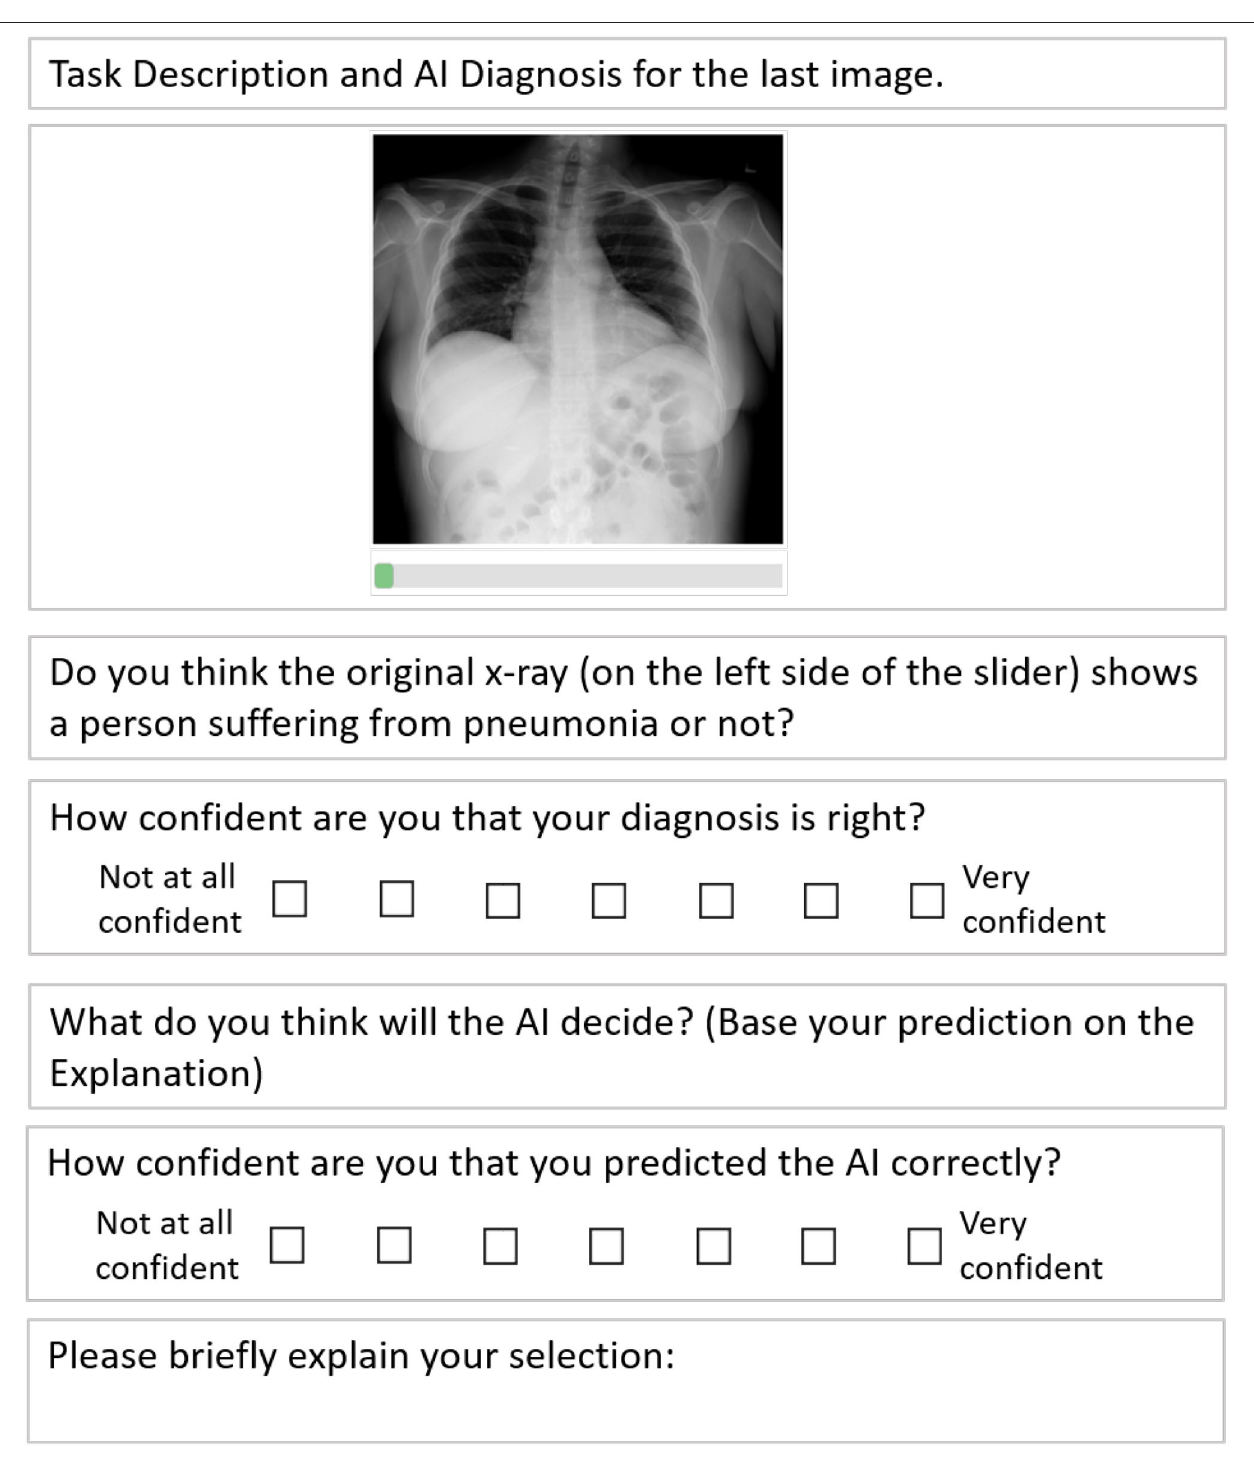
FIGURE 6 | A simplified schematic of our prediction task.